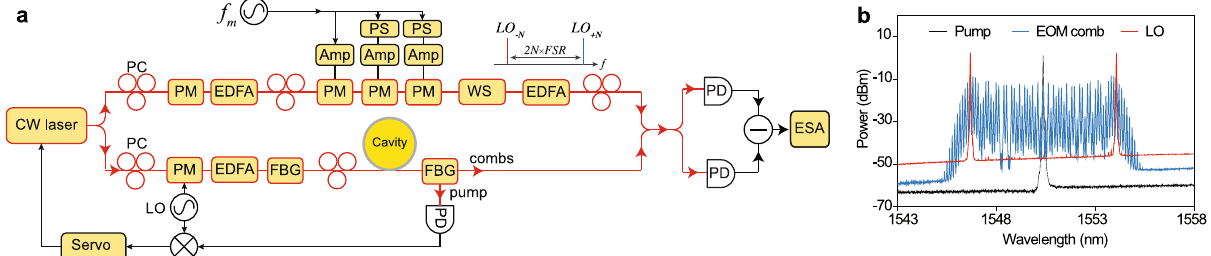
Fig. 5 Experimental setup and optical spectrum of local oscillators. a Optical and microwave components are colored in red and black boxes, respectively. A continuous-wave (cw) laser drives both the squeezed microcomb and the local oscillators. Part of the cw laser is ampli fi ed by an erbium-doped fi ber ampli fi er (EDFA) to pump the silica microresonator. A fi ber-Bragg grating (FBG) fi lter is used at the microresonator through port to separate the pump light and the squeezed light. The local oscillators are derived from an electro-optic modulation (EOM) frequency comb, which is driven by the same cw laser. The cw laser is phase modulated by three tandem phase modulators (PMs) at frequency f m . A programmable waveshaper (WS) is used to select a pair of comb lines to be the local oscillators. The LOs and the squeezed microcomb are combined and detected on the balanced photodetectors (PDs). The noise variance is characterized by an electrical spectrum analyzer (ESA). Polarization controller (PC), electrical ampli fi er (Amp), and phase shifter (PS) are also included in this fi gure. b Optical spectra of the pump laser (black), the EOM frequency comb (blue), and the local oscillators (red) for qumodes ( − 21, 21).